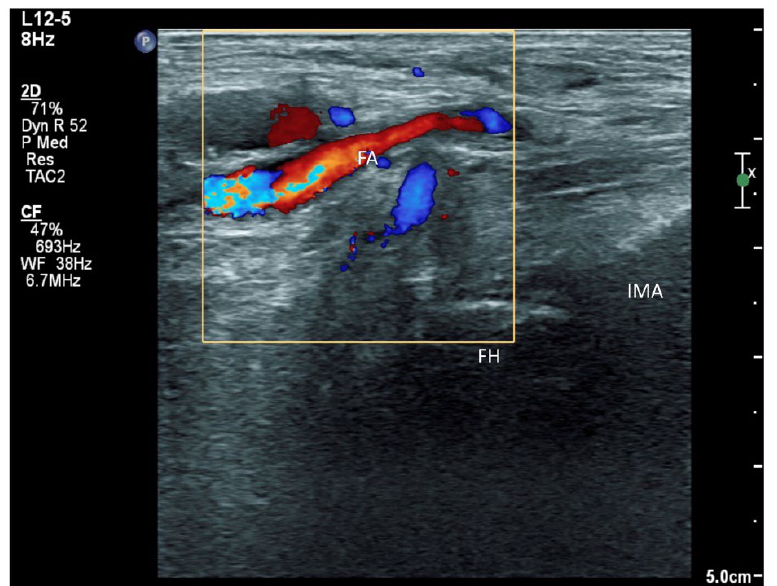
Figure 8. Doppler signal of the femoral artery and its branches when scanning the inferomedial acetabulum by the classical oblique approach. FH: femoral head, FA: femoral artery and branches, IMA: inferomedial acetabulum.